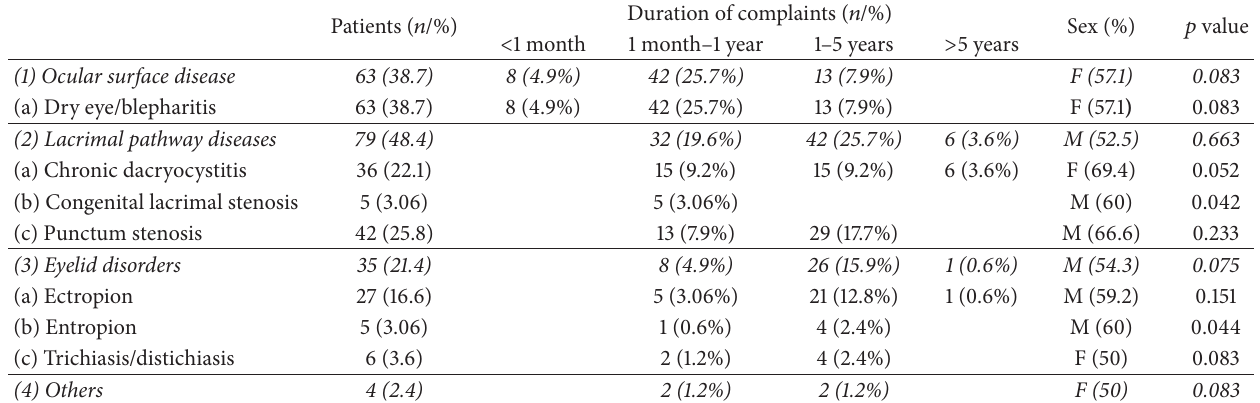
Table 1: Causes of epiphora, duration of complaints, and relationship with gender. Patients ( 𝑛